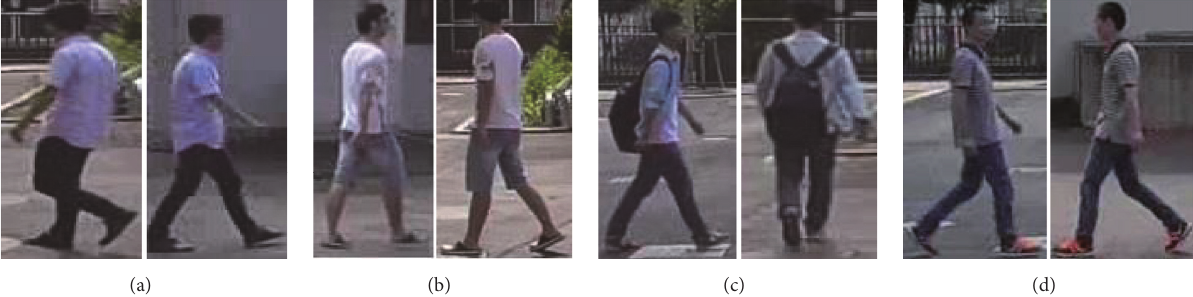
Figure 1: Images showing the same person in different camera views: (a) pose change, (b) illumination change, (c) occlusion, and (d) low